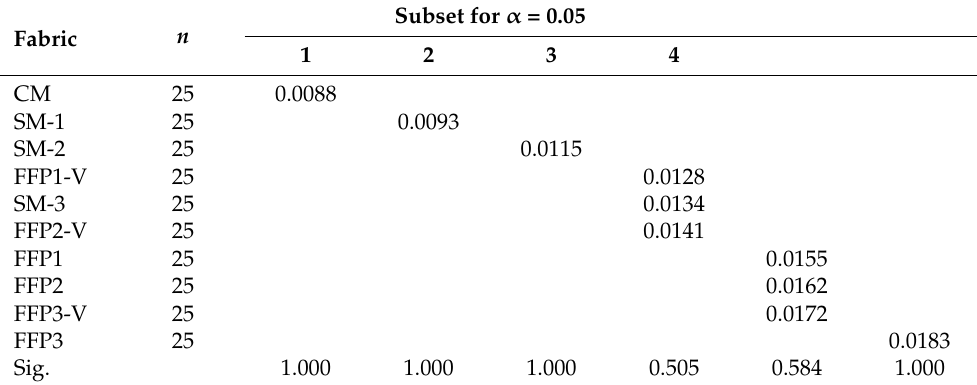
Table 4. The results of SNK post hoc tests of the thermal resistance values. Fabric